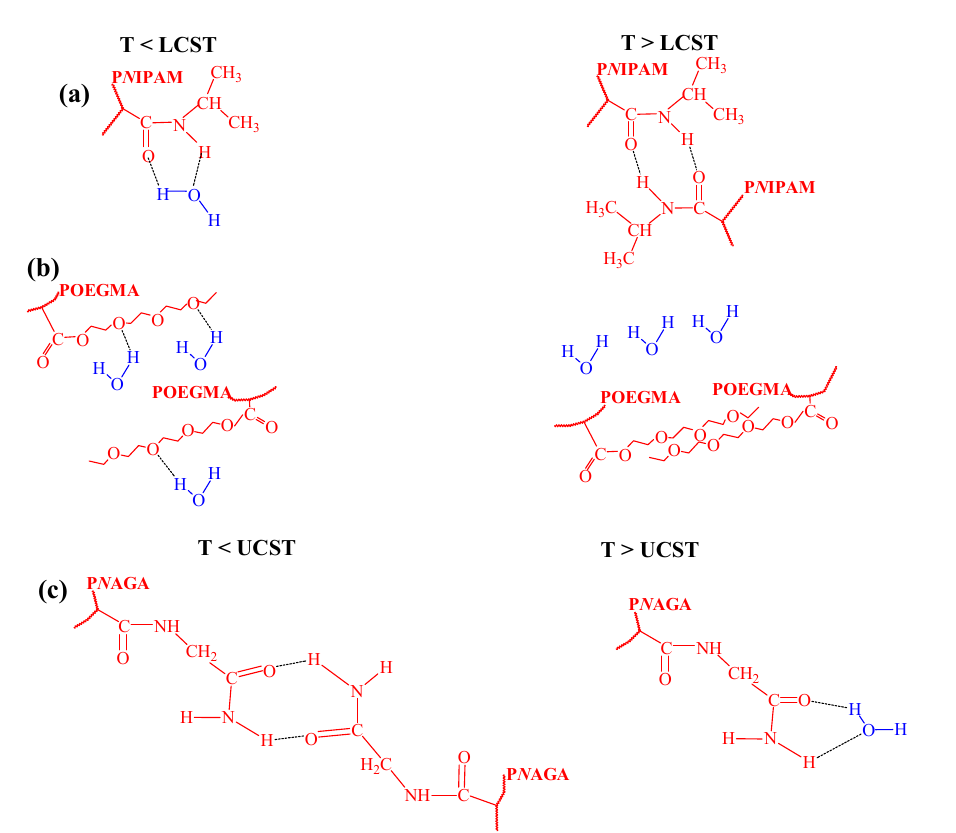
Figure 3. The simplified mechanisms of the LCST or UCST transitions for N IPAM ( a ), OEGMA ( b ) and N AGA ( c ) based TRPBCs.